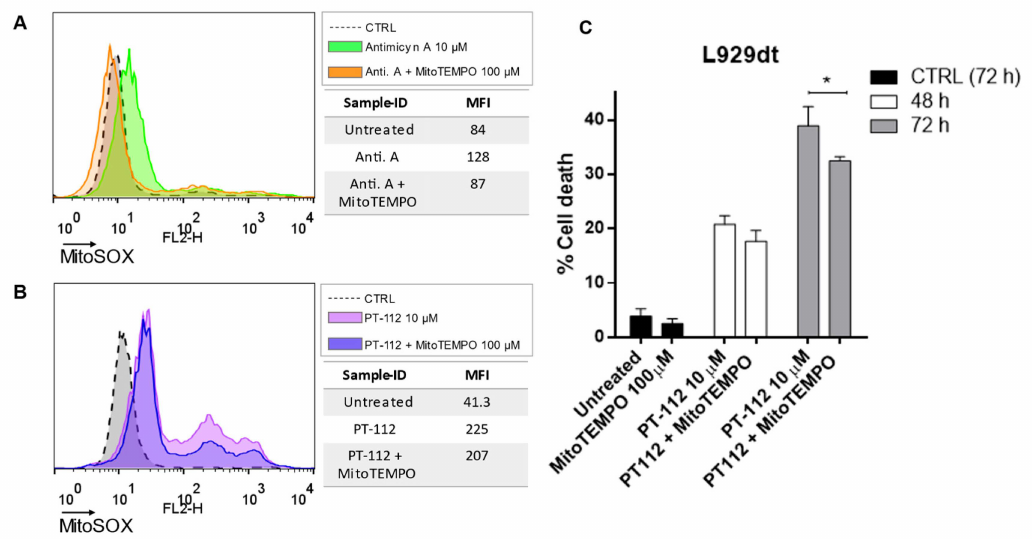
Figure 7. Partial inhibition of PT-112-induced mtROS generation and cell death in L929dt cells by the mtROS scavenger MitoTempo. A total of 3 × 10 4 cells were seeded in a 96-well plate in phenol red-free medium and some wells were incubated with 100 µ M of MitoTEMPO for 2 h. Then, 10 µ M of antimycin A or PT-112 were added and incubated for 48 or 72 h, respectively. ( A , B ) mtROS levels were measured using MitoSOX™ staining after treatment with either ( A ) antimycin A or ( B ) PT-112. ( C ) Cell death induced by PT-112 in the presence or absence of MitoTEMPO after 48 or 72 h was evaluated by flow cytometry using annexin-V-FITC and 7-AAD staining. Results are shown as mean ± SD of at least 2 independent experiments performed in duplicate. * p < 0.05.